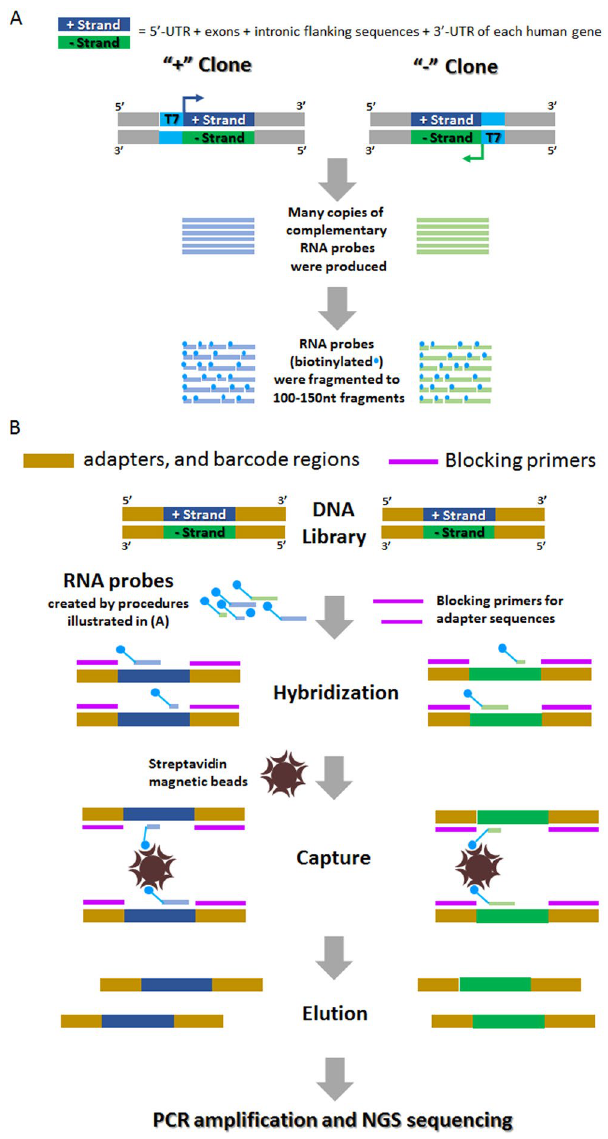
Figure 2. Overview of DEEPER-Capture procedure. ( A ) Overview of RNA probe production. Target DNA sequences are cloned into pcDNA 6.2 vector. Two clones for each target sequence are constructed, with a T7 promoter inserted upstream of the target sequence on either strand. For each DNA target sequence, in the “ + ” clone, T7 promoter is inserted at the 5 ′ end of the plus strand of the target sequence; and in the “ − ” clone, T7 promoter is inserted at the 5 ′ end of the minus strand of the target sequence. “ + ” clone and “ − ” clone for each target sequence are separated into 2 pools and are subject to in vitro transcription to produce biotin labeled RNA probes individually. 2 pools of RNA probes are then sheared into 100-150nt RNA fragments by ultrasonication. ( B ) Overview of DEEPER-Capture workflow. A hybridization mixture is prepared by first heated dissociation of double-stranded DNA molecules in the library, blocking primers and two pools of RNA probes are added into the system sequentially in a heated environment. After hybridization, streptavidin beads are used to isolate RNA probes and their hybridized DNA targets from the system. Target DNA sequences are then eluted from the beads and subject to PCR amplification and NGS